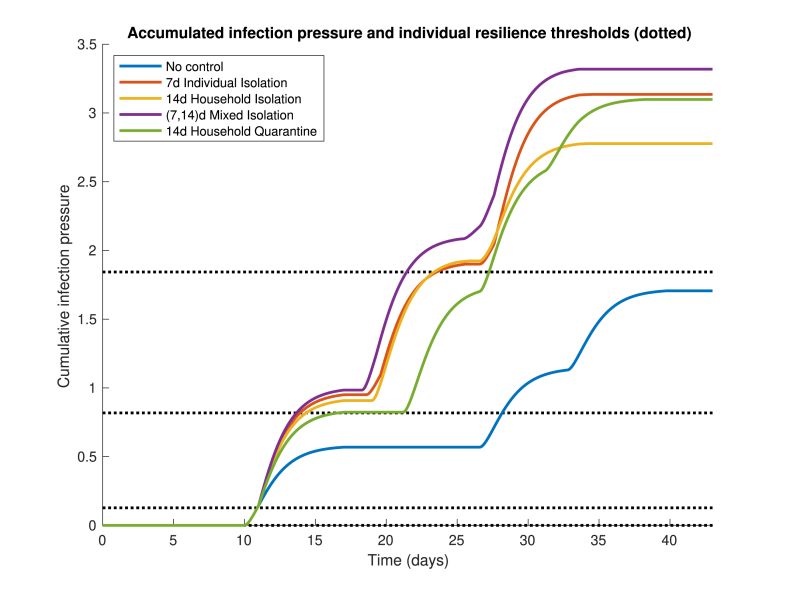
Accumulated infection pressure in the simulation presented in Fig. 8 for different control policies. Horizontal dotted lines represent individuals’ resilience thresholds. As time progresses, the accumulated infection pressures (coloured lines) increase and when they cross the resilience thresholds, the corresponding individual acquires infection. Notice that: in the absence of control, one individual escapes infection; with household isolation only, the infection pressure reaches a relatively low endpoint because of the last symptomatic individual slipping through and not transmitting much in the household; with mixed isolation, infection pressure is higher due to combined adherence; and with household quarantine, the infection pressure builds up more slowly at the beginning due to lower adherence. We assume that adherence to individual isolation is 90%, household isolation is 80% and household quarantine is 60%.